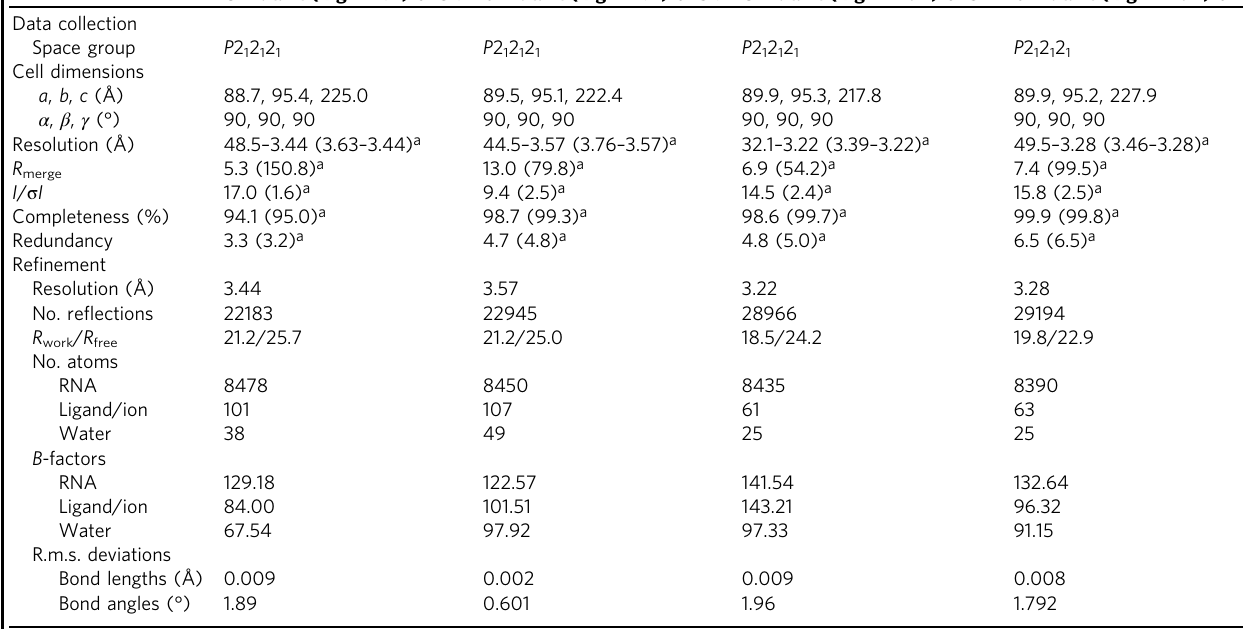
Table 1 Data collection and re fi nement statistics (molecular